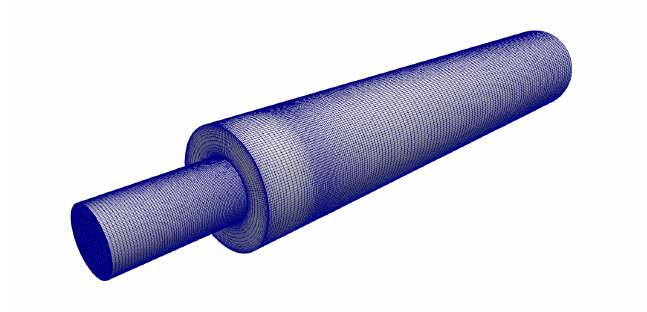
Figure 8. Numerical mesh for abrupt expansion test